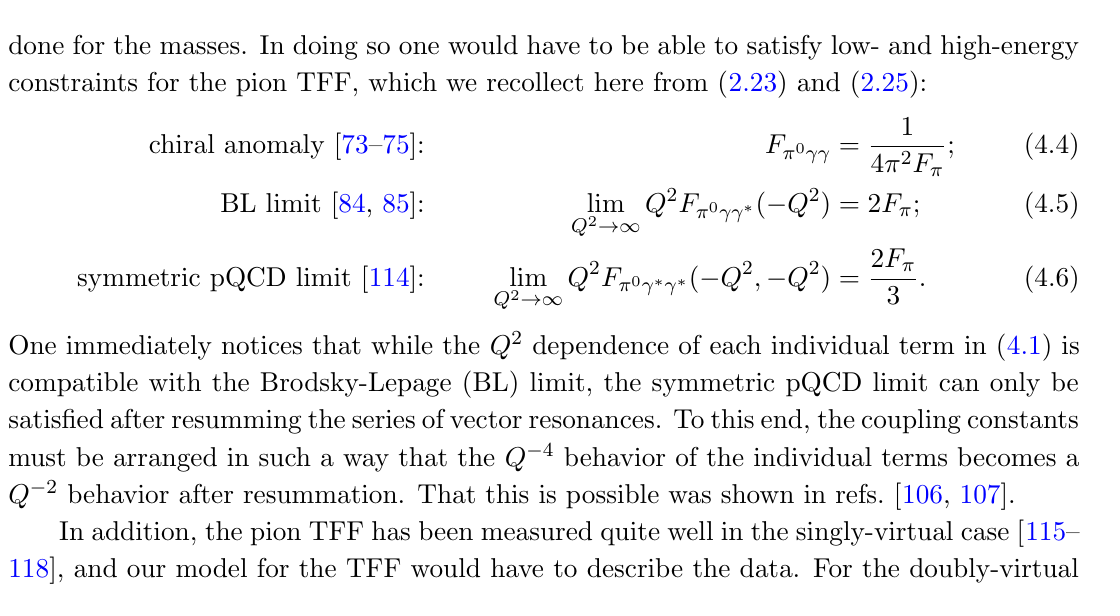
= 1 : 54, (cid:27) 2 = ! (cid:26) = 1 : 50(12) GeV 2 , !